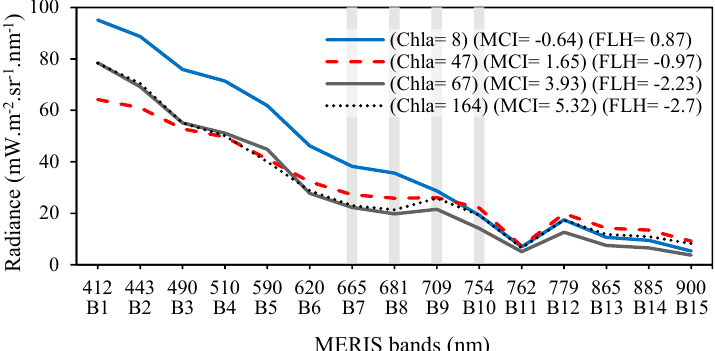
Figure 2. MERIS L1b top-of-atmosphere radiance spectra of Lake Kasumigaura at several chlorophyll-a concentrations with the corresponding values of maximum chlorophyll index (MCI) and fluorescence line height (FLH). The grey columns highlight MERIS bands that are used for FLH and MCI. Chla is in (mg · m − 3 ). MCI and FLH are in (mW · m − 2 · sr − 1 · nm − 1